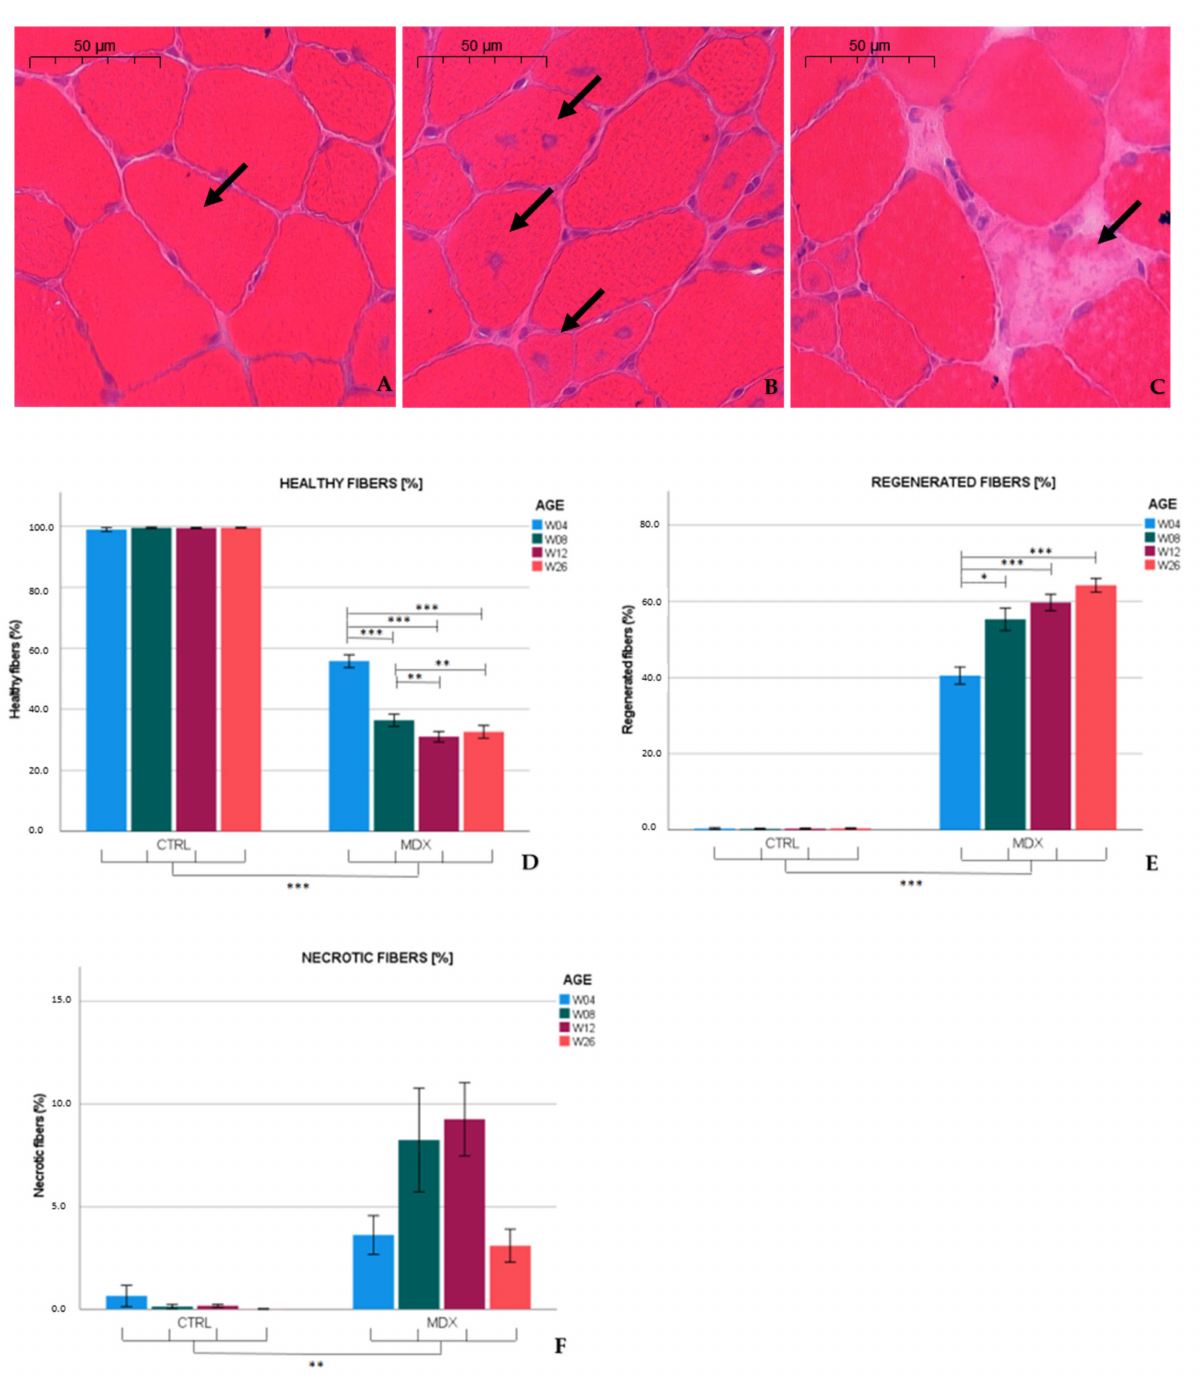
Figure 1. Histopathological characteristics of the mdx mouse model. ( A – C ) Haematoxylin-Eosin (H&E) stained mdx muscle sections. ( A ) Arrow indicates a healthy muscle fiber with nuclei at the peripheral site. ( B ) Arrows indicate a group of regenerating fibers with centralized nuclei. ( C ) Arrow indicates a necrotic fiber characterized by loss of membrane integrity and pale cytoplasmic aspect. ( D ) Quantification of the percentage of healthy fibers, ( E ) regenerated fibers with central nuclei, and ( F ) necrotic fibers counted in the tibialis anterior of mdx and control mice aged 4, 8, 12, and 26 weeks. Results were based on manual scoring of 5 H&E stained sections per animal taken approximately 150 µ m apart ( n = 5 animals per age group). A total of 199 sections were analyzed. Data presented as the mean ± standard error of the mean (SEM). Significant differences are annotated by * ( p ≤ 0.05), ** ( p ≤ 0.01) and *** ( p ≤